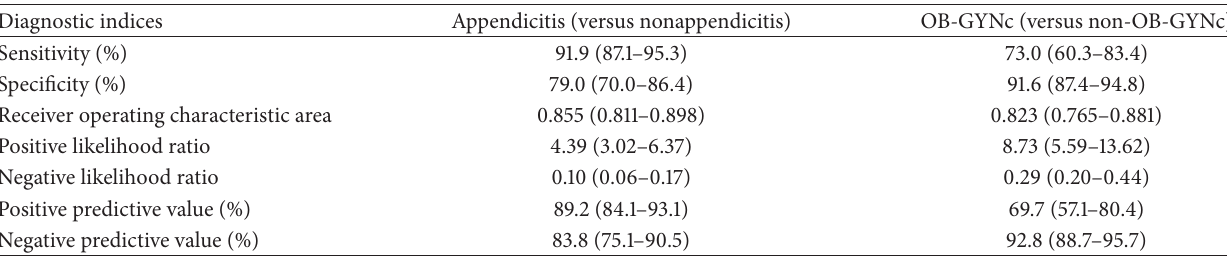
Table 5: Diagnostic indices (and 95% confidence interval) of the scoring system for appendicitis (versus nonappendicitis) and OB-GYNc (versus non-OB-GYNc) in the validation data (based on final professional diagnosis).